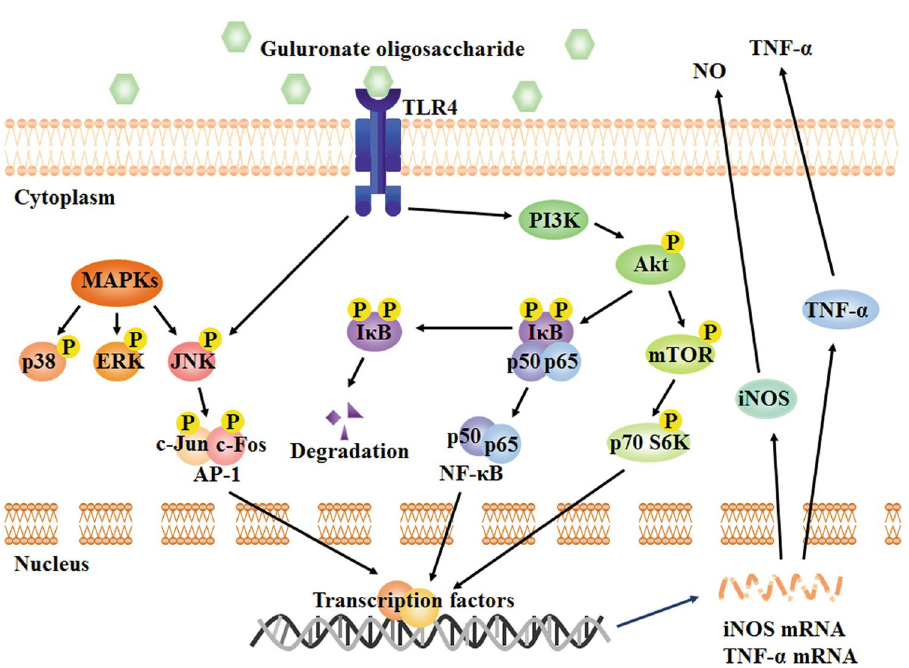
Figure 8. Signalling pathways involved in the macrophage activation effect of alginate-derived guluronate